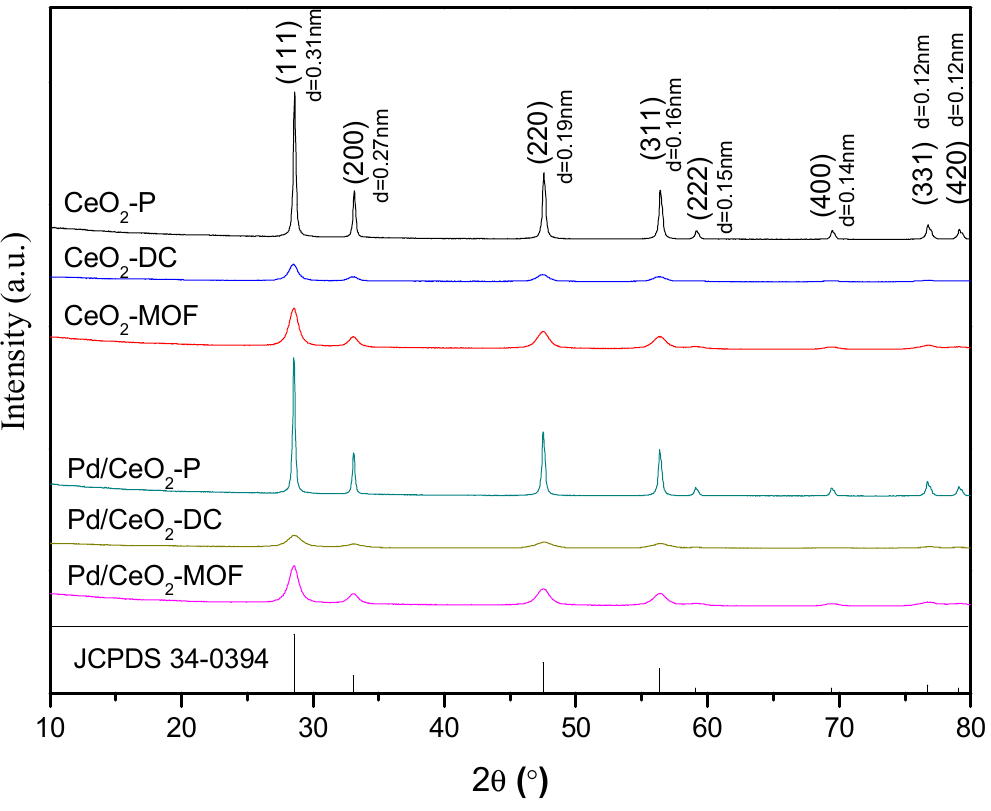
Figure 3. XRD patterns of the samples.